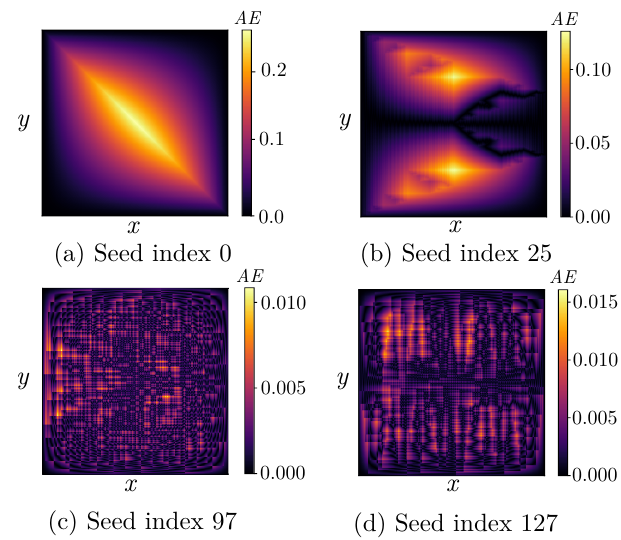
Figure 7. Absolute Error (AE) in the multiplication when varying x , y (from 0 to 1) using different seeds in the 8-bit LFSR example. Seed index = 0, which is the worst case, is shown in ( a ). Seed index = 25, which is one of the resonant error peaks, is shown in ( b ). Seed index = 97, which is the best case, is shown in ( c ). Furthermore, seed index = 127, which is the further seed index is shown in ( d